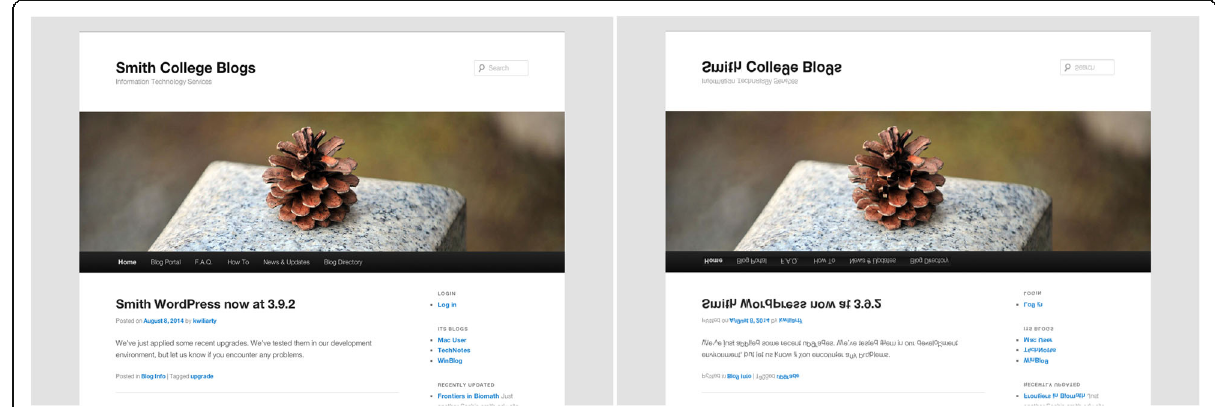
Fig. 5 Screenshot of a blog web page (left), and the text-scrambled version (right)